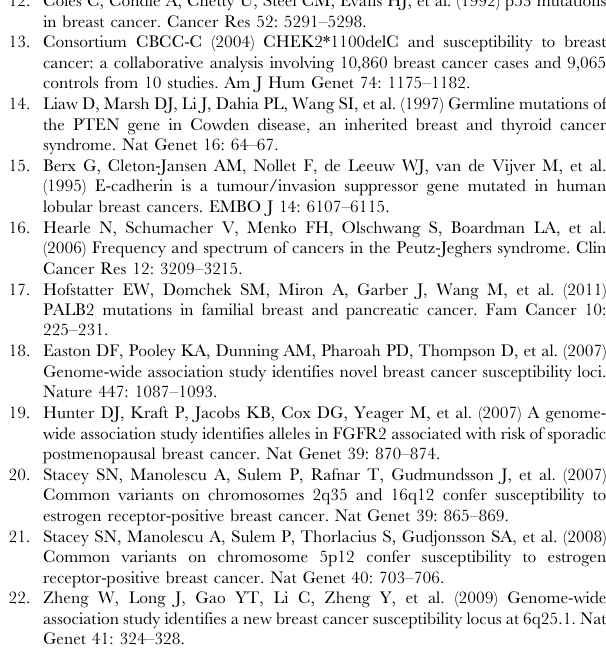
Table S3 Haplotype analysis and association of SNPs on chromosome 16q12.1. Table S4 Association study of previously reported breast cancer associated loci.